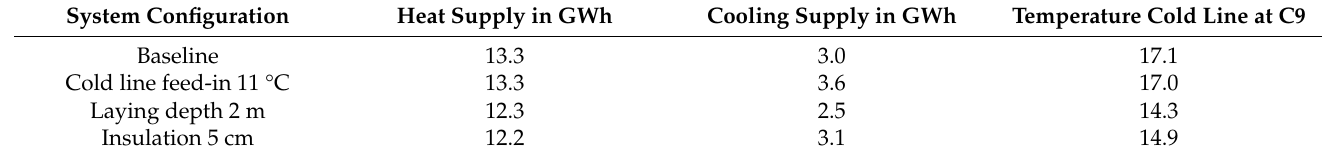
Table 5. Comparison of central heat and cooling supply and cold line temperatures at cluster C9.